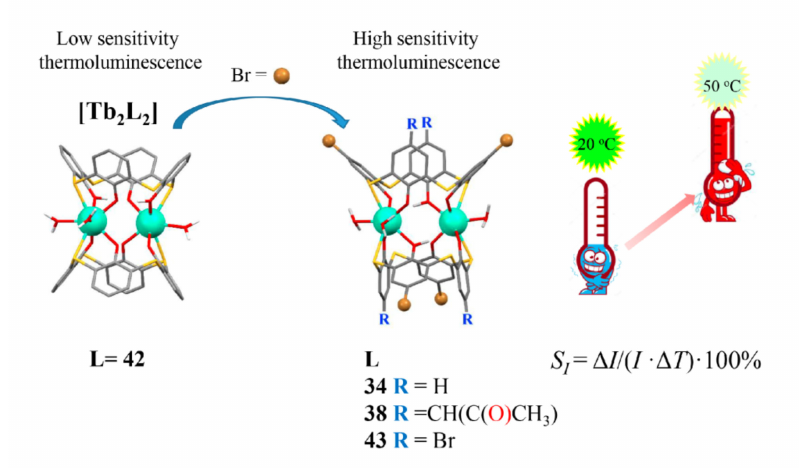
Figure 8. Cartoon illustration of the impact of the bromo-substitution on the thermal sensitivity of Tb 3+ -centered luminescence for dimeric complexes with the thiacalix[4]arene derivatives Redrawn from reference [60] with permission from the Royal Society of